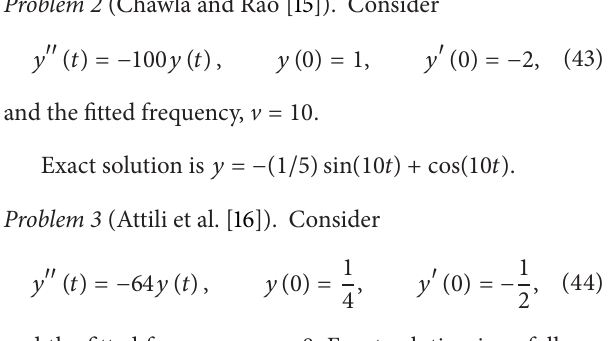
Figure 2: The efficiency curves of the optimized and phase-fitted order five methods and their comparisons for Problem 3 with 𝑡 10 4 and ℎ = 0.125/2 𝑖 , 𝑖 = 1, ...,5 .